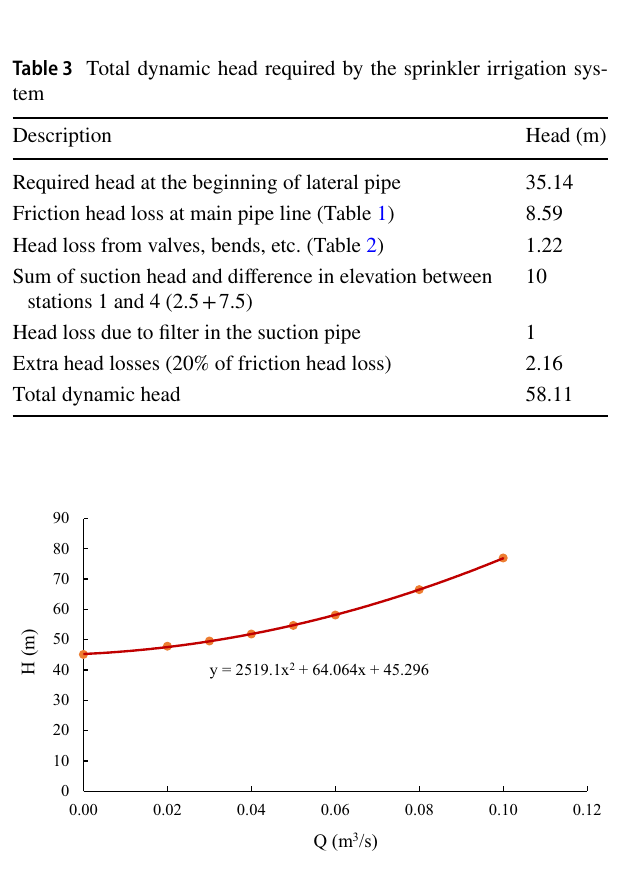
Fig. 4 System curve for sprinkler irrigation network